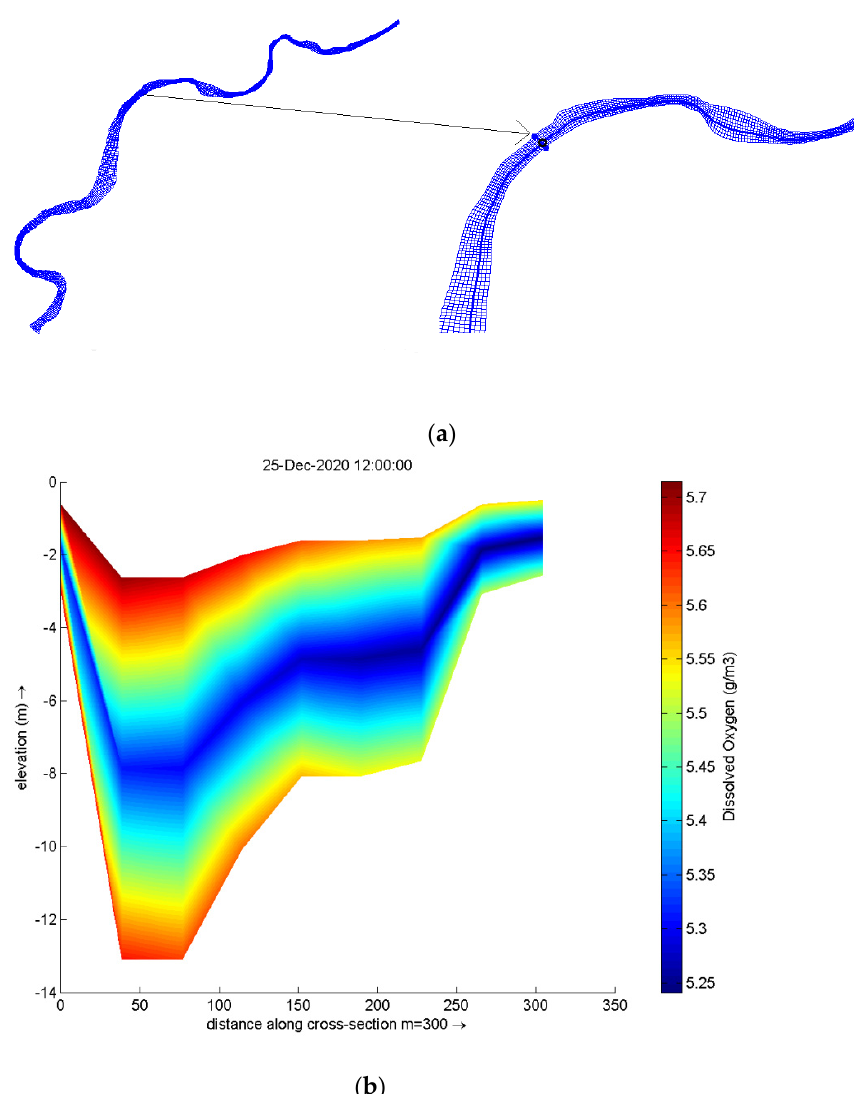
Figure 10. ( a ) Location of the cross section for sampling point #47. ( b ) Dissolved oxygen concentration for sampling point #47.